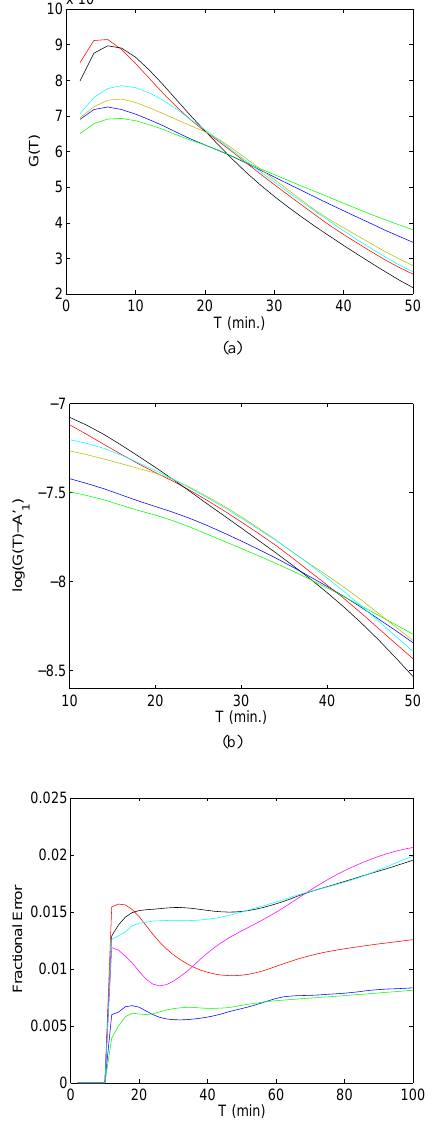
1 The cores of jets show low mixing regions (blue) in the FTLE field as there is very little relative advection of neighboring trajec- tories there. Jets are bounded by high shear regions, which lead to large relative advection (red) and large FTLE values.